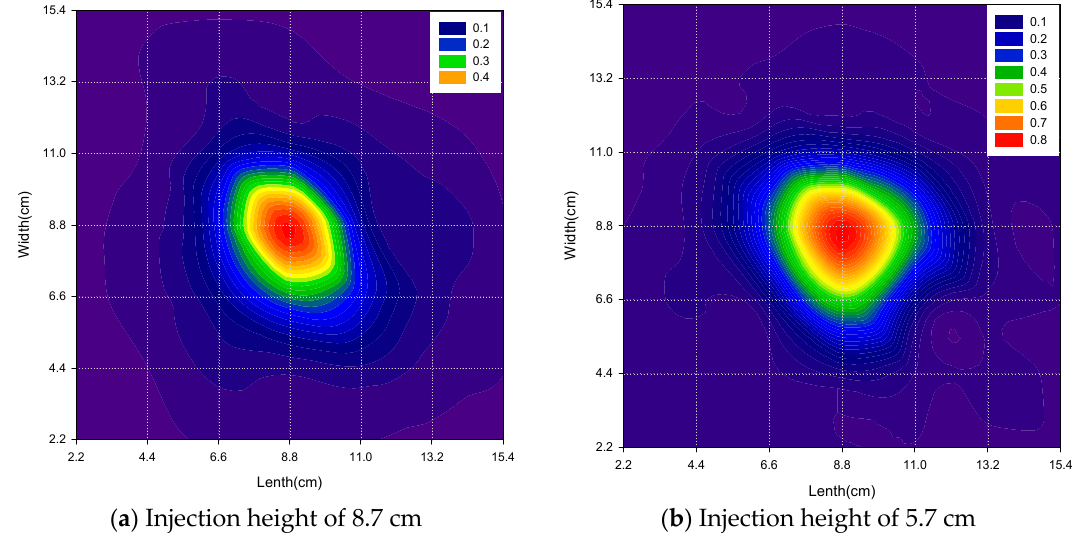
Figure 4. Ion precipitation contour distribution at different injection heights.